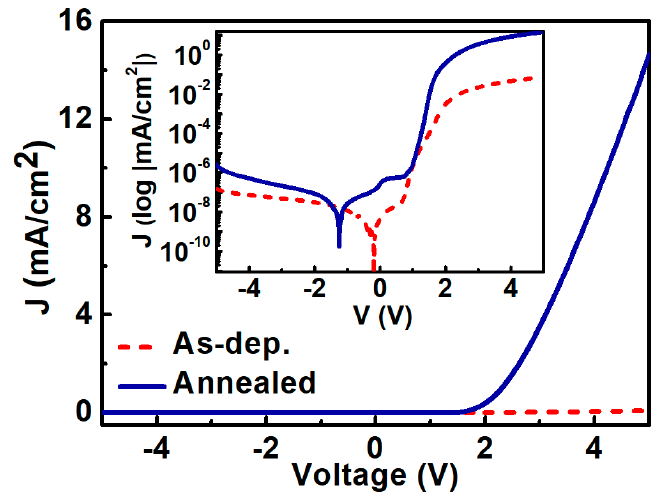
Figure 2. J-V curves of as-deposited (before annealing) and annealed AlN Schottky barrier diodes.